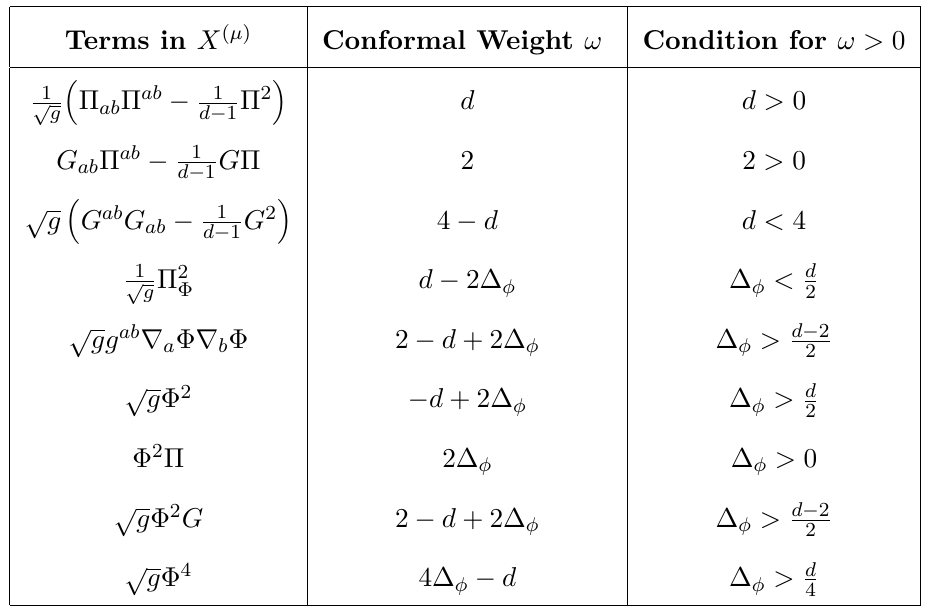
Table 1 . “Relevancy” of the terms in X ( µ ) for the counterterms chosen in (2.52).